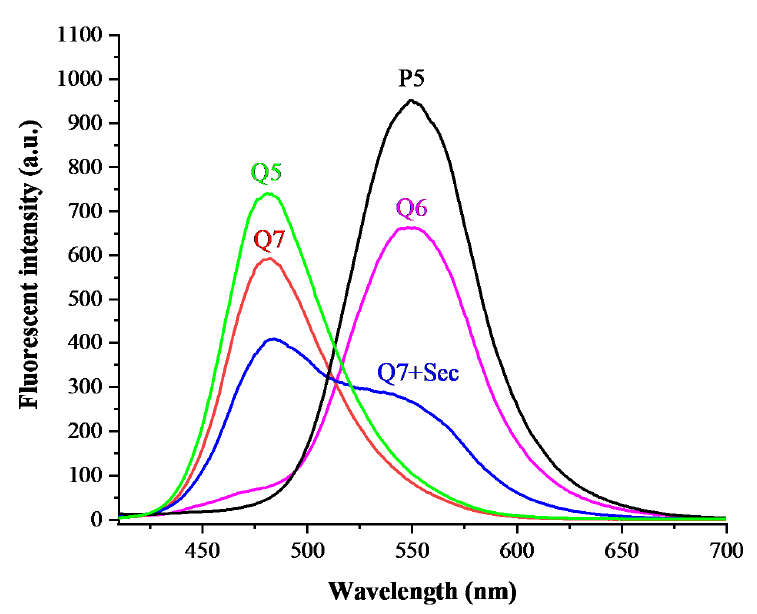
Figure 2. Fluorescence spectra of 1 μ M P5 (black), Q5 (green), Q6 (pink), Q7 (red), and Q7 reacting with 10 μ M Sec (blue) in DMSO/PBS = 1:99 ( v / v ), excited at 400 nm.